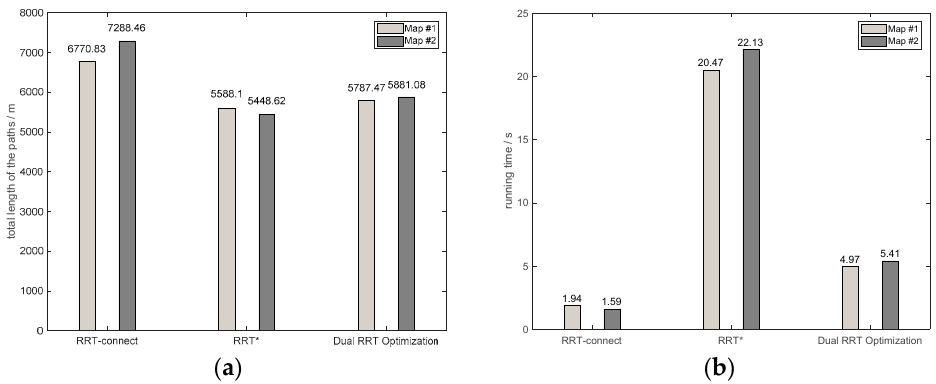
Figure 20. Total path result length and running time for each algorithm under different maps. ( a ) is the total length of the path result for each algorithm; ( b ) is the running time of each algorithm for different numbers of vehicles.